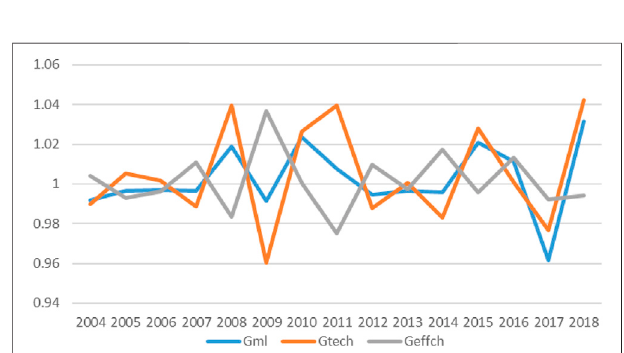
FIGURE 3 | The Gml, Gtech, and Geffch indexes of resource-based cities in China from 2004 to